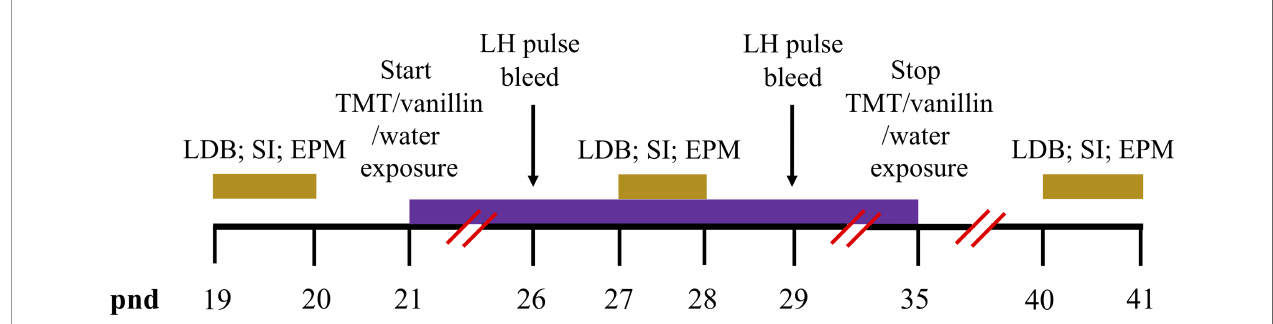
FIGURE 1 | Timeline schematics for the effect of TMT exposure on puberty, pre-pubertal pulsatile LH secretion and anxiety-like behaviour. Time in post-natal days (pnd) is indicated by the black horizontal line. Female C57Bl6/J mice anxiety-like behaviour was tested on the light-dark box (LDB), social interaction (SI) and elevated plus maze (EPM) on pnd 19 and 20, pnd 27 and 28 and pnd 40 and 41 (gold bars). Chronic exposure to 2,4,5-Trimethylthiazole (TMT) or vanillin or water began on pnd 21 and lasted for 14 days until pnd 35 (purple bar). Pre-pubertal pulsatile luteinising hormone (LH) secretion was tested on pnd 26 and 29 (black arrows).